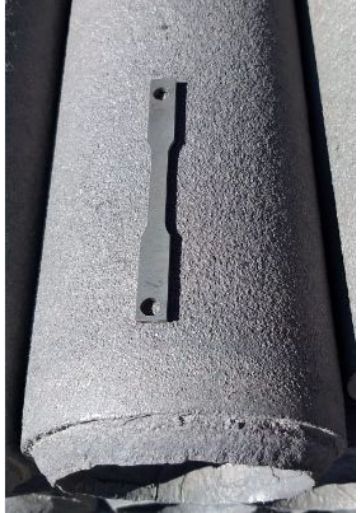
Figure 5. Tensile test specimen.